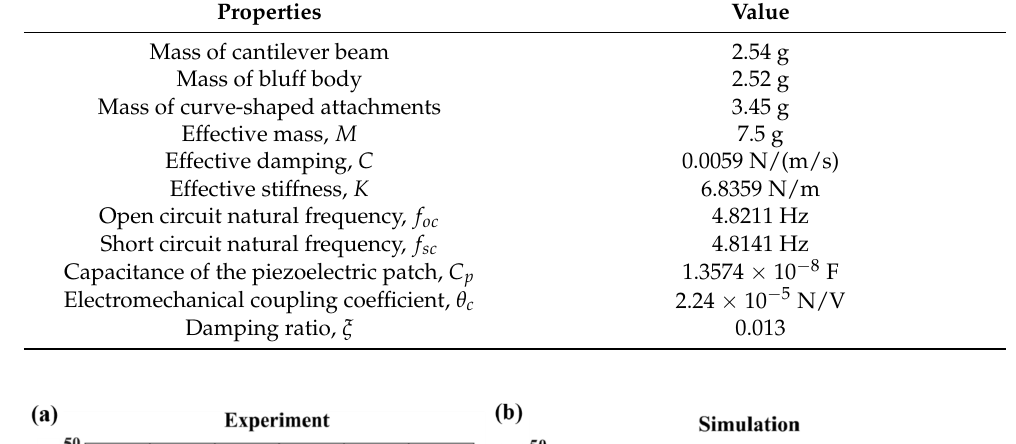
Table 1. Parameters of the piezoelectric wind energy harvester.